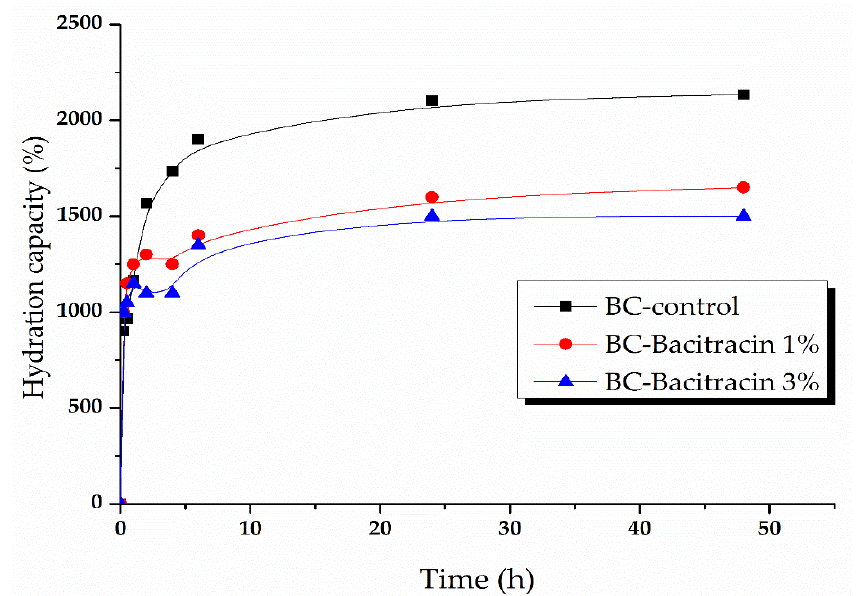
Figure 7. Absorption kinetics of BC samples loaded with bacitracin 1% and 3%.